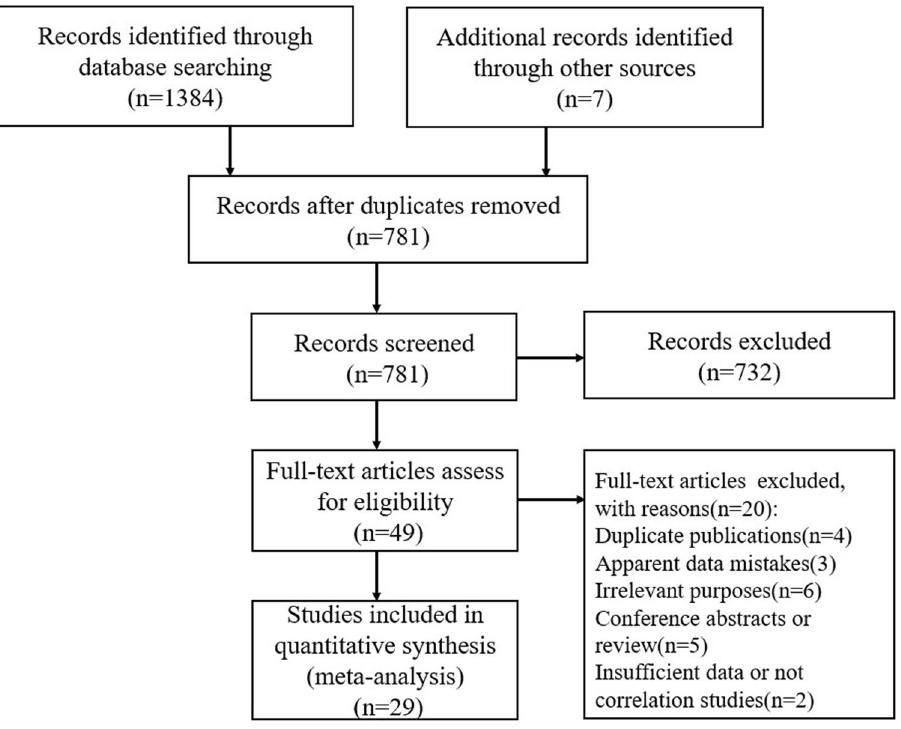
Figure 1. Flow diagram of the search